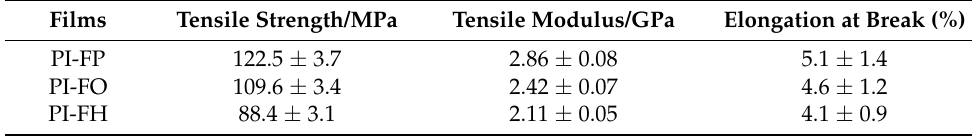
Table 5. The tensile strength, tensile modulus, and elongation at break of PI